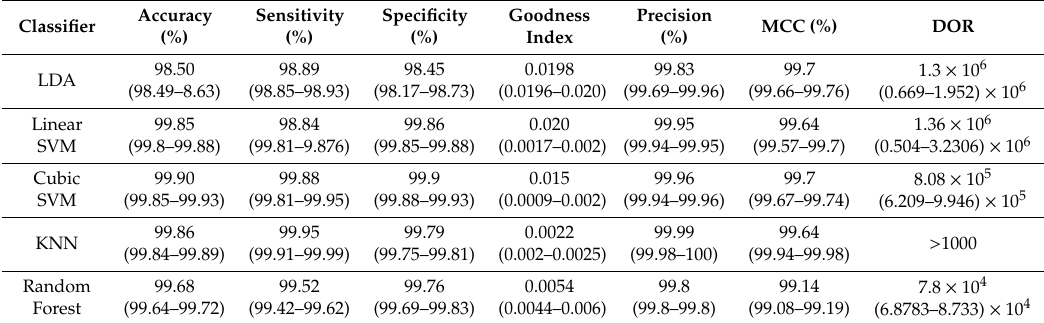
Figure 6. The classification accuracies for classifying stress levels using our three subsets of features . Table 4. Evaluation metrics (with their 95% confidence intervals) for evaluating stress levels using Feature-Set 3 . Classifier